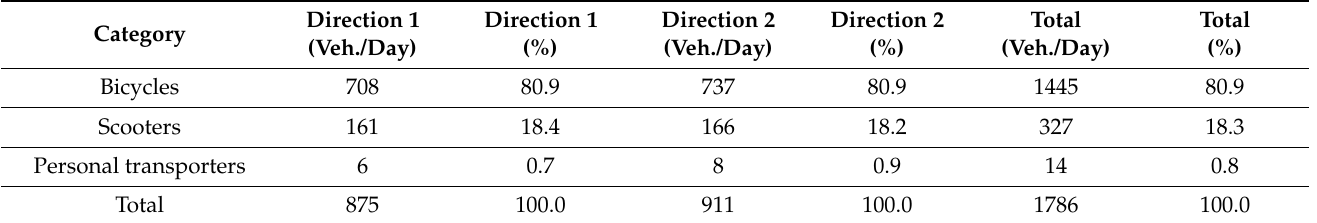
Table 4. Vehicle structure type at the bicycle lane along ´Swi˛etokrzyska street, broken down by measurement days (own